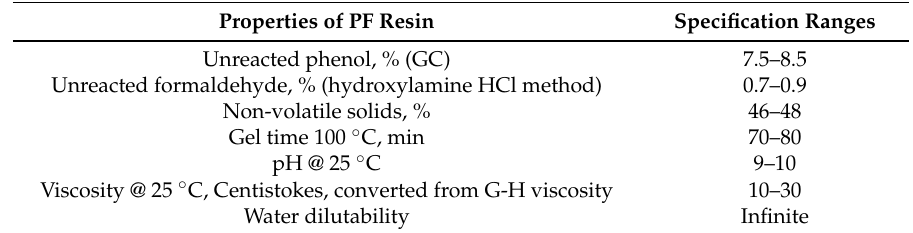
Table 3. Properties of low molecular weight phenol formaldehyde resin used to treat test